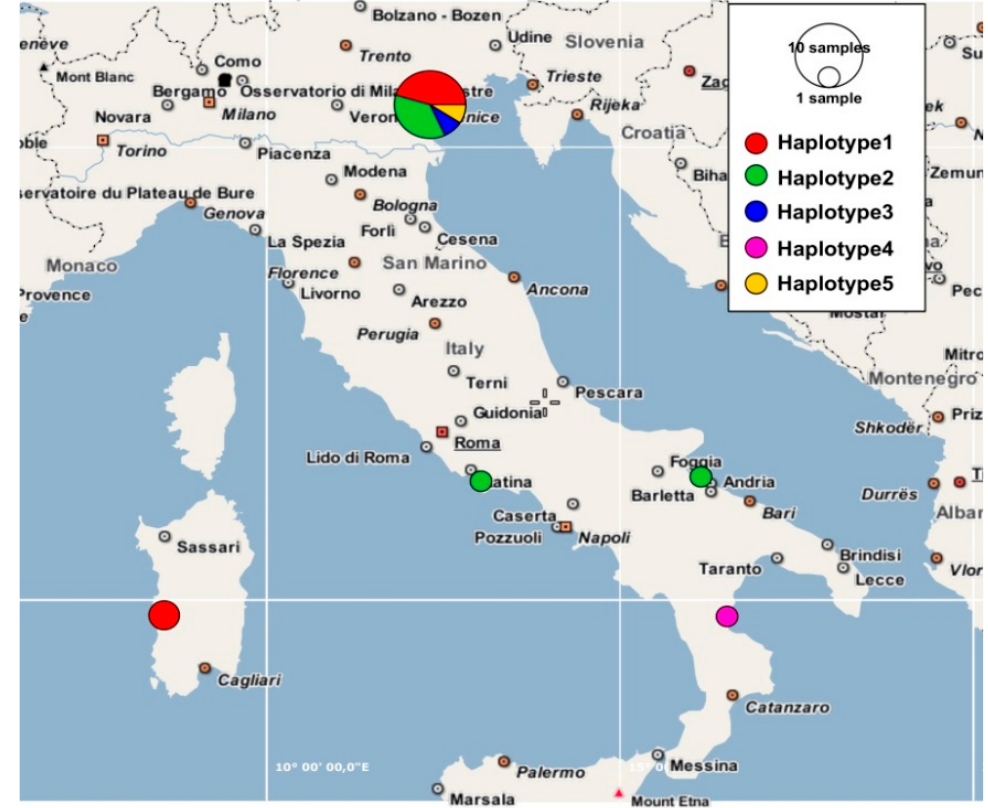
Figure 9. Frequencies of different Italian plastid psb A -trn H haplotypes plotted in a geographical map for the genus Salicornia .